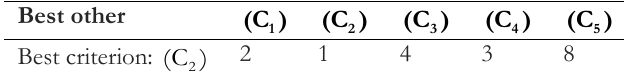
Table 2. BO pairwise comparison.